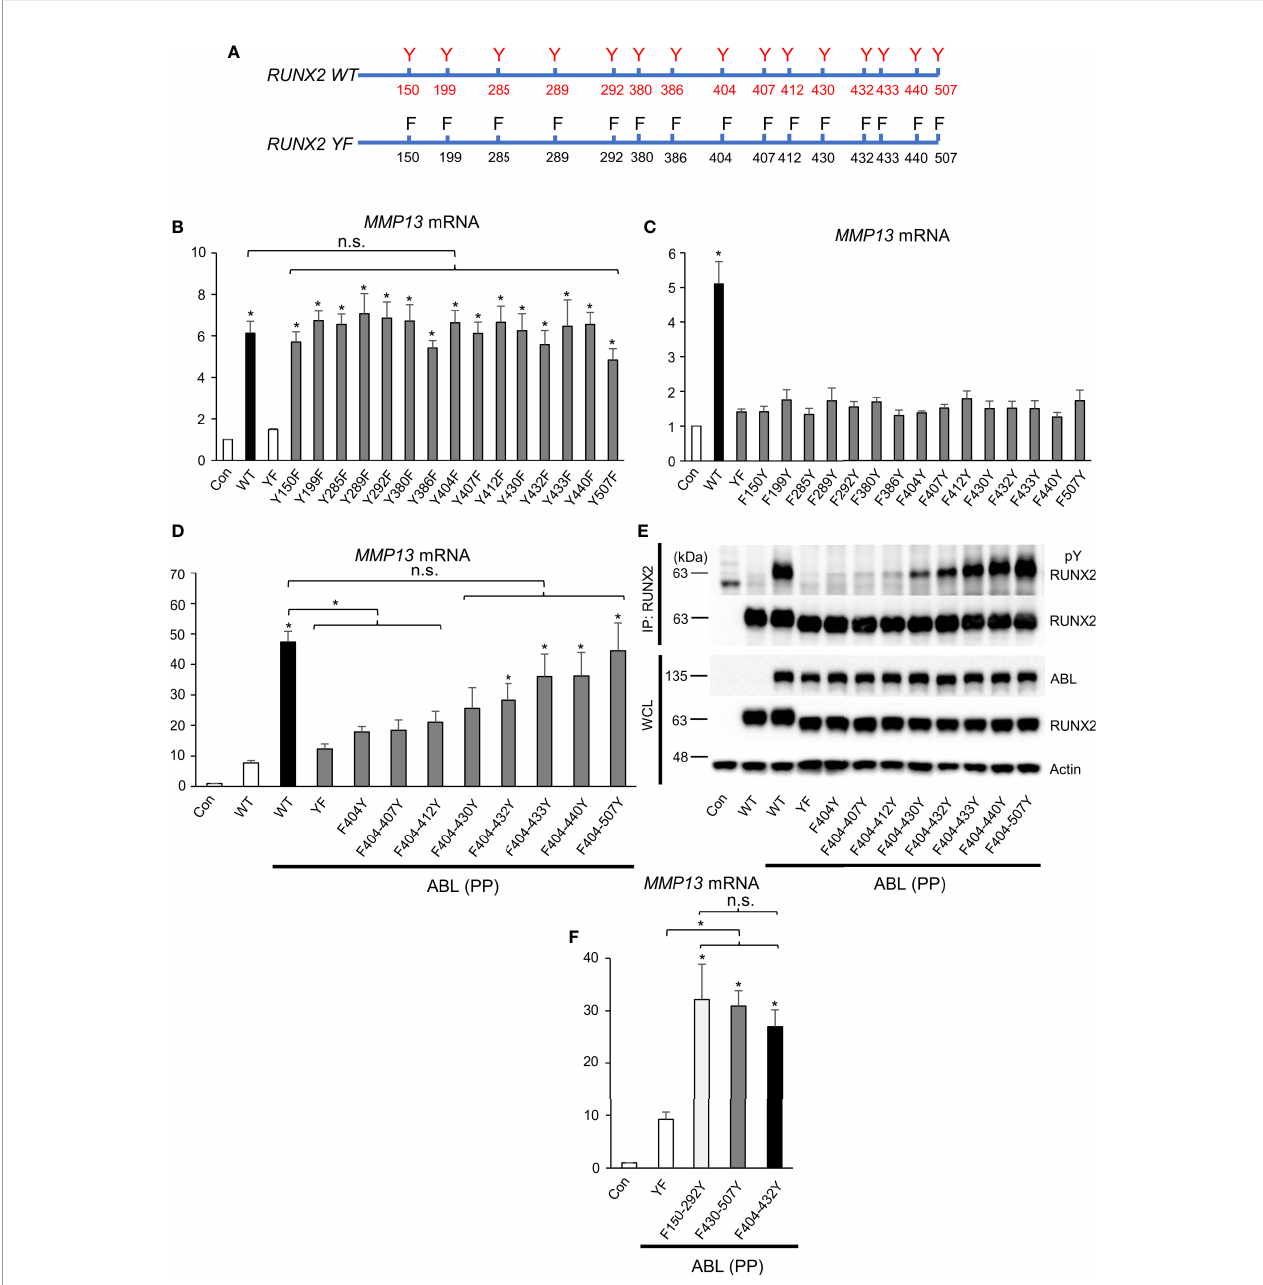
FIGURE 3 | RUNX2 transcriptional activity is dependent on the number of its tyrosine residues phosphorylated by ABL. (A) Schematic models of RUNX2 (WT) and RUNX2 (YF). (B – D, F) Quantitative PCR analysis of MMP13 mRNA expression in HEK293T cells co-transfected with the indicated constructs. n = 3. (E) HEK293T cells were co-transfected with the indicated constructs and RUNX2 immune complexes were probed with an anti-4G10 or anti-RUNX2 antibody. P values were determined by ANOVA with Tukey – Kramer ’ s post hoc test. Data are presented as means ± SEM. *P < 0.05. ns, no signi fi